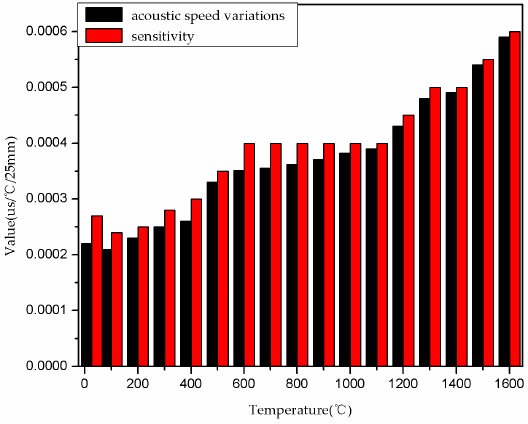
Figure 10. Value of sensitivity and acoustic speed variations.